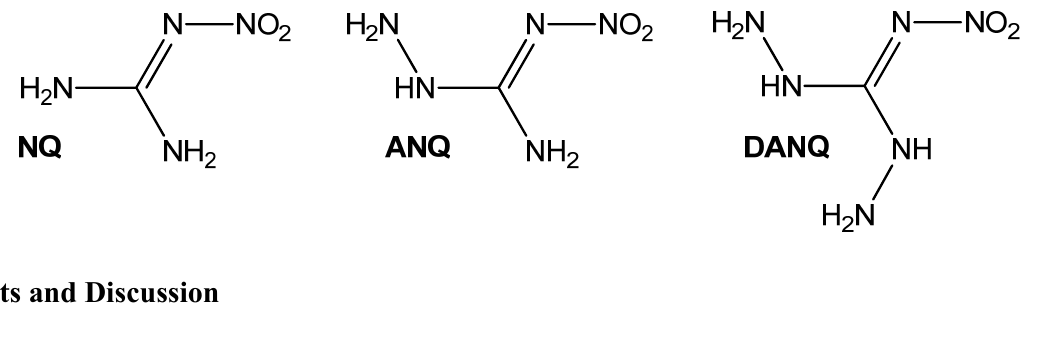
1. Chemical structures of amino-nitroguanidines: NQ : 1-nitroguanidine, ANQ : 1-amino-3-nitroguanidine, DANQ : 1,3-Diamino-5-nitroguanidine (not known